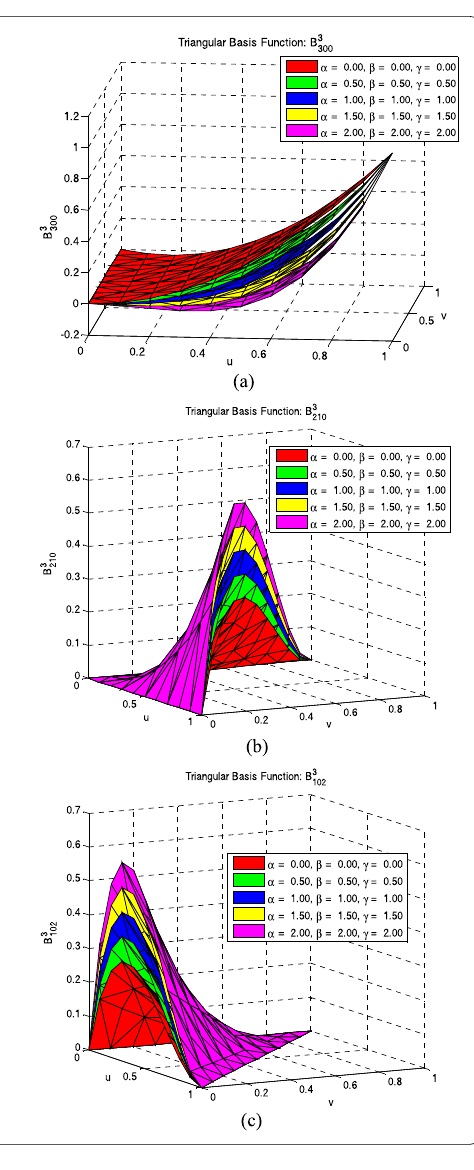
Figure 5 Vertices and edges of the triangle from [21]